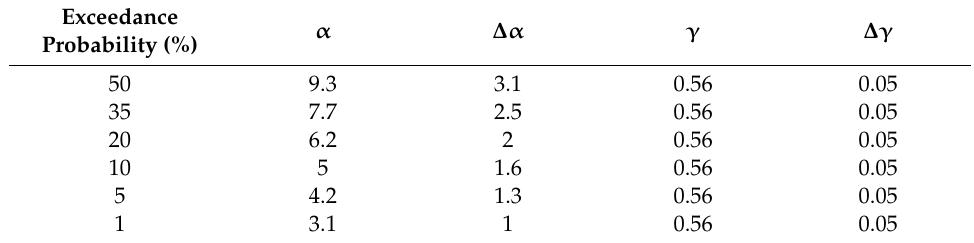
Table 2. Parameters α and γ , and related uncertainties ∆ α and ∆ γ at various exceedance